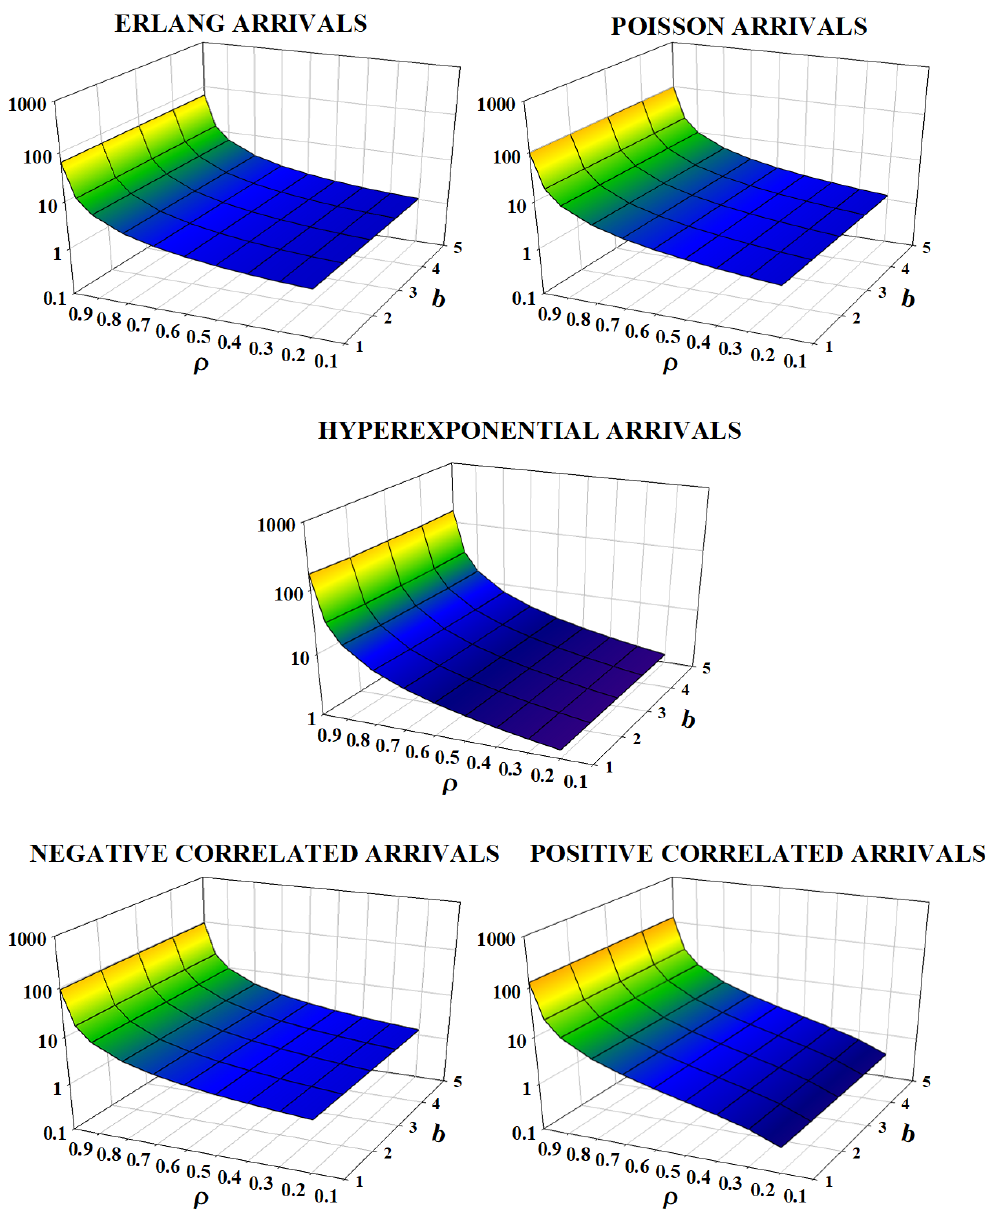
Figure 10. Mean recurrence time ( µ (cid:48)